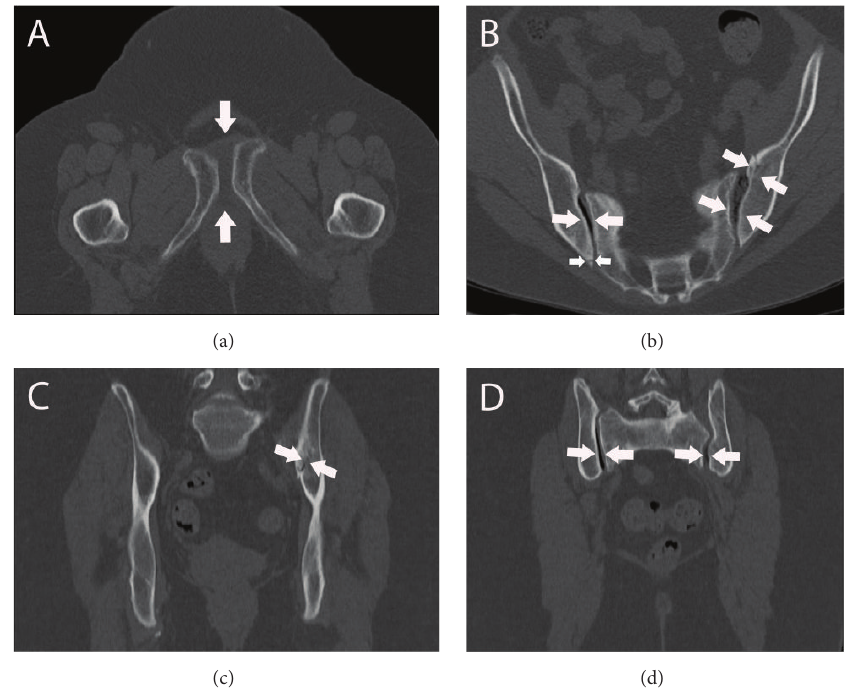
Figure 3: The CT-scan of the pelvic girdle confirms the observations of MR-image. (a) Axial CT-scan presented widening of the symphysis (arrows). (b) Axial CT-scan offered vacuum phenomenon in both sacroiliac joints, small tearing out in the left sacroiliac joint, and small dorsal fracture fragment in the right dorsal ilium (arrows). (c) Coronary CT-scan revealed the fracture line in the left ilium (arrows). (d) Coronary CT-scan presented vacuum phenomena in both sacroiliac joints (arrows).